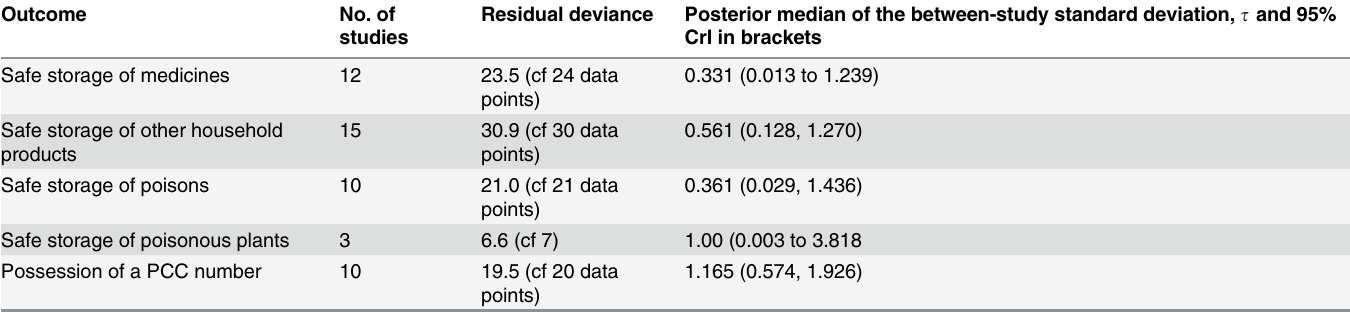
Table 1. Evaluation of model